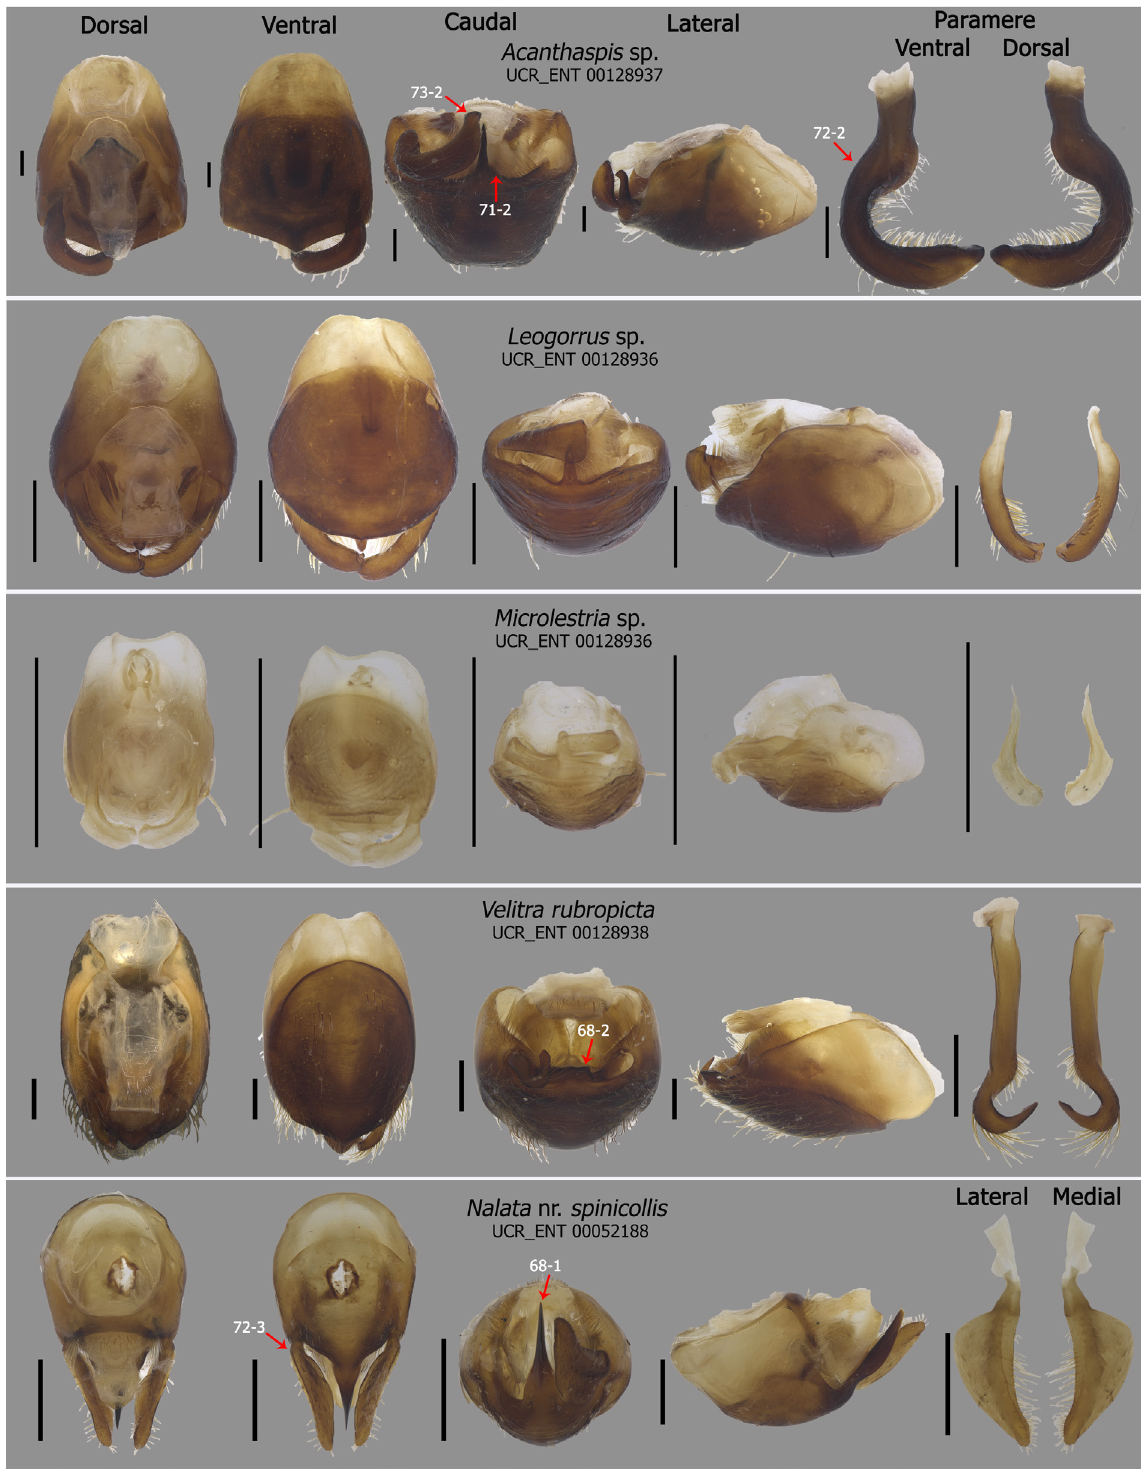
Fig. 15. Pygophore of outgroup species. Scale bars = 0.5